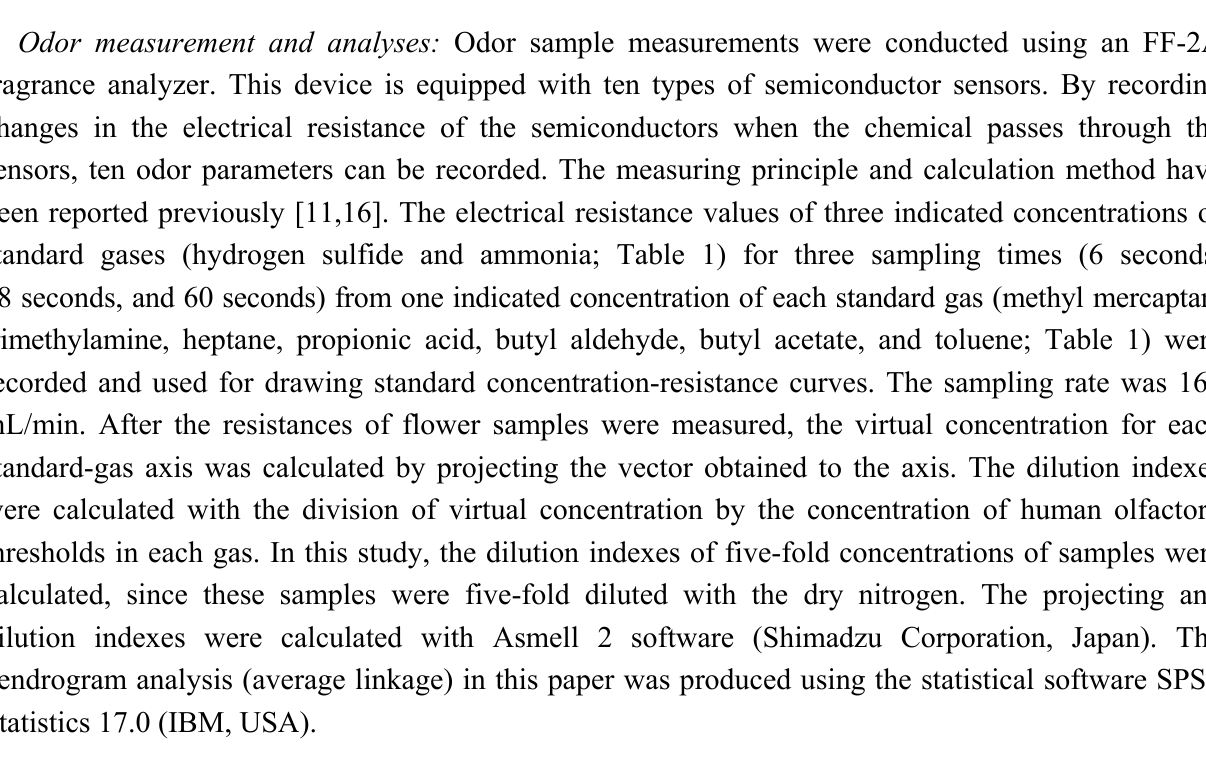
Table 1. Standard gases and metaphor